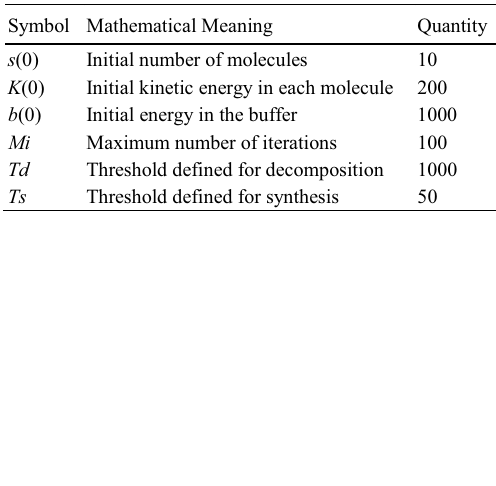
Table 1. Main parameters of CRO algorithm.